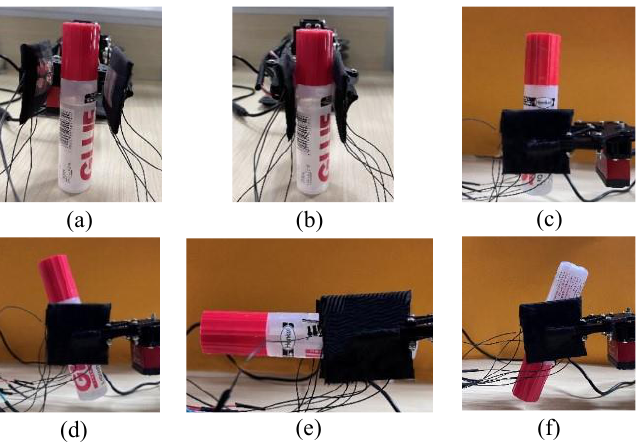
Figure 7. The statuses of gasping an object (glue set) with the two-finger actuator ( a ) Initial state; ( b ) The object is fully touched by the two tactile sensor arrays on the two-finger actuator; ( c ) The object is grasped at the first position; ( d ) The object is grasped at the second position; ( e ) The object is grasped at the third position; ( f ) The object is grasped at the fourth position.